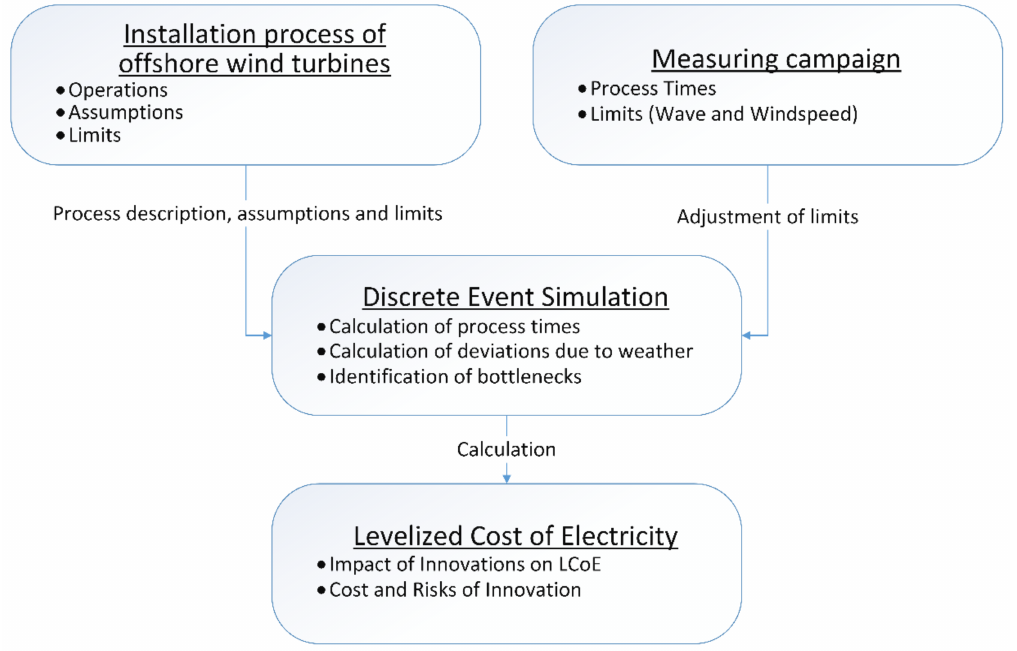
Figure 1. Concept of connecting simulation and measurement